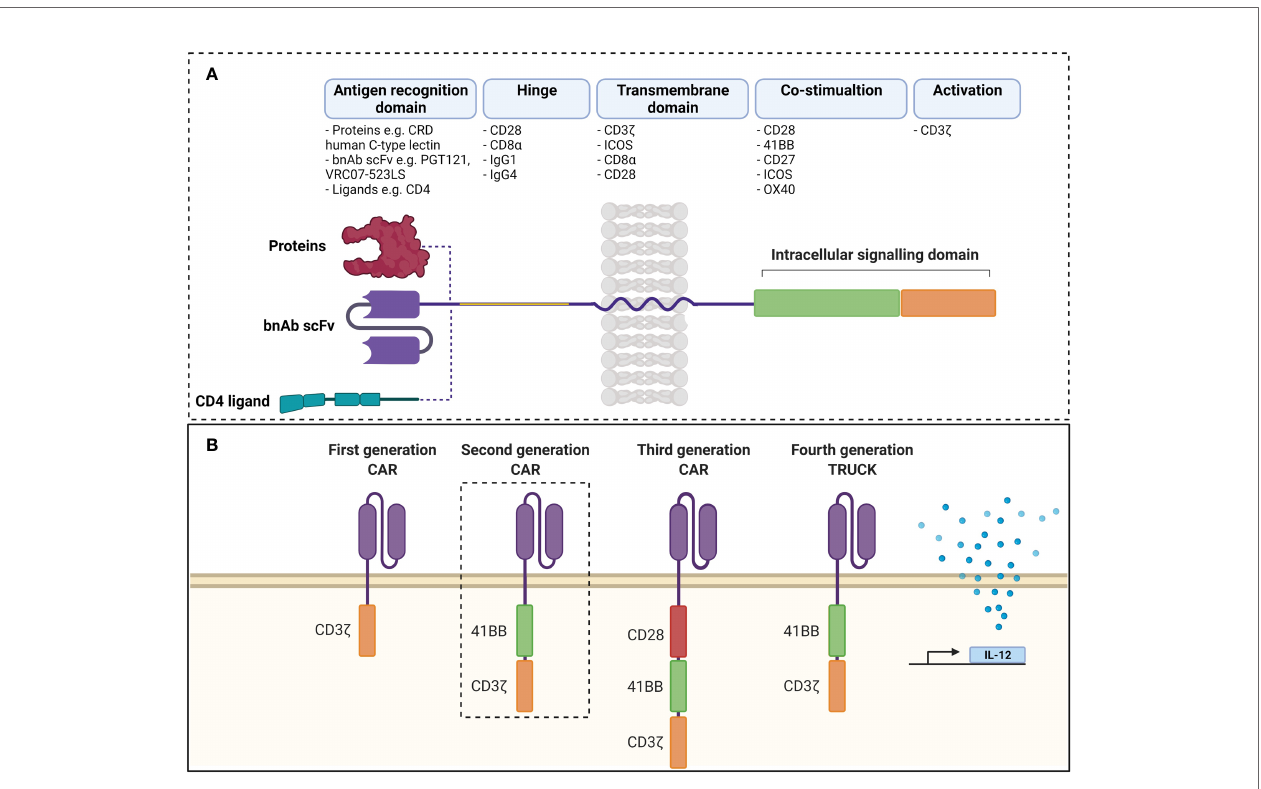
FIGURE 1 | (A) Structure of chimeric antigen receptor. Antigen receptor domains are linked to transmembrane domains and intracellular signalling domains consisting of co- stimulatory domains and CD3 z by hinge regions. scFvs are common as antigen recognition domains, although ligands can be used to take advantage of ligand-receptor interactions. (B) Evolution of chimeric antigen receptors. Antigen recognition domains are linked to CD3 z in fi rst generation CARs and activity was improved by addition of co- stimulatory domains in second and third generations. Fourth generation TRUCKs include inducible transcription of transgenes (such as IL-12) to second generation CARs. scFv, single chain variable fragment; CAR, chimeric antigen receptor TRUCK, T cell redirected for universal cytokine killing; bnAb, broadly neutralising antibody; CRD, carbohydrate recognition domain. Created with BioRender. Adapted from Ra fi q et al.